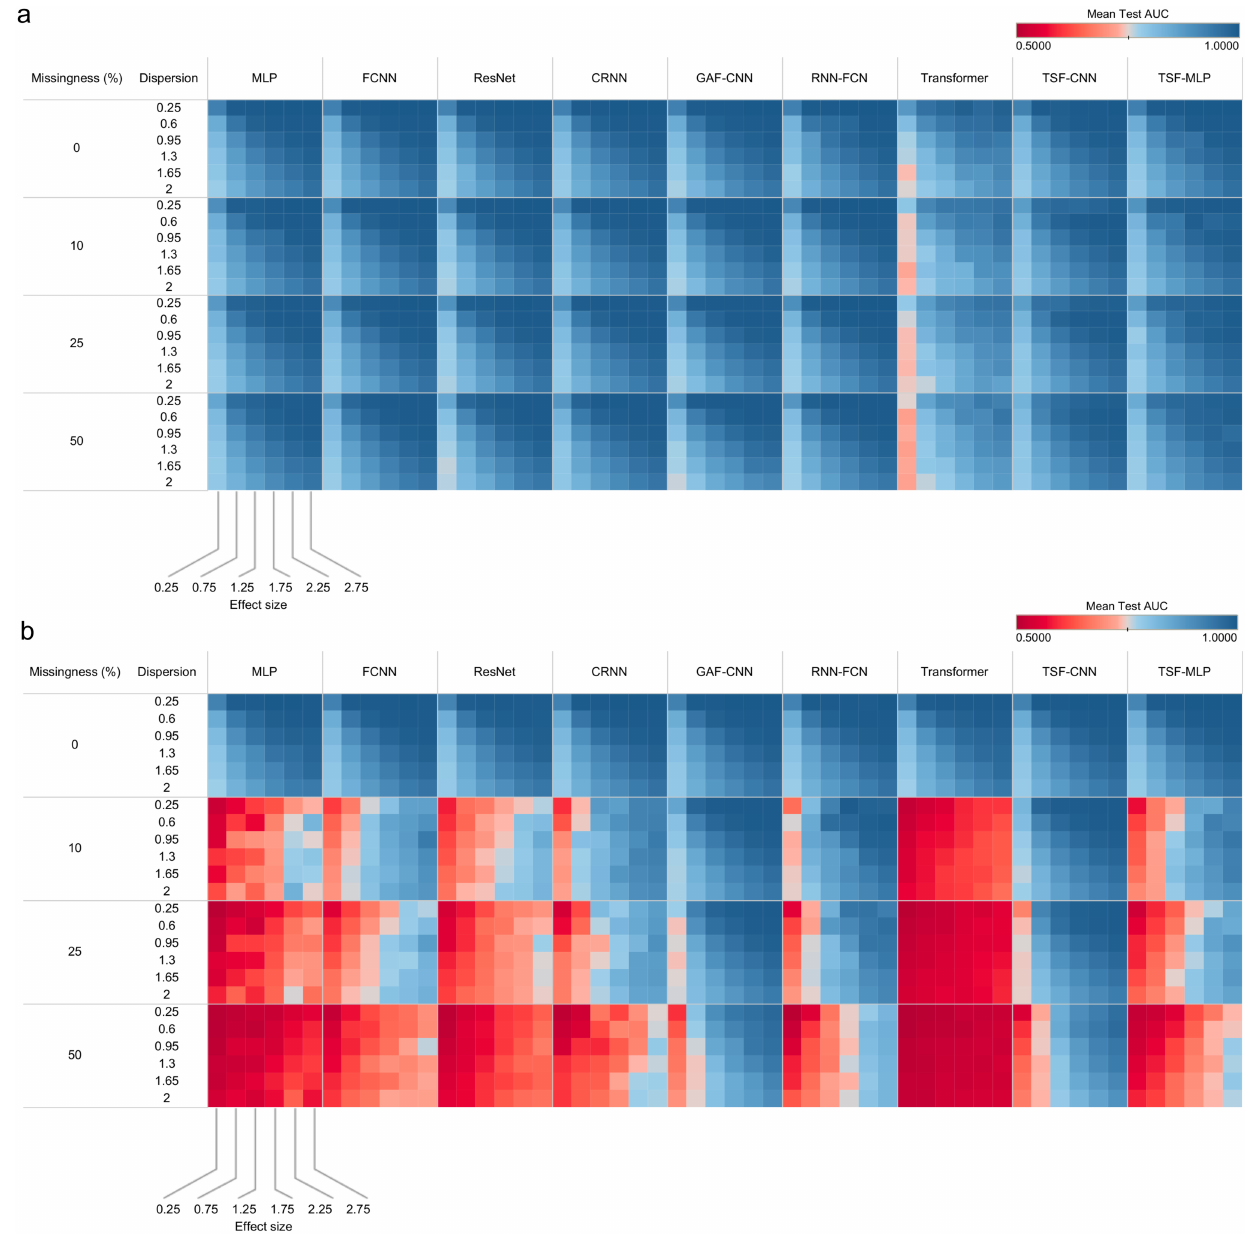
Fig. 2 Model predictive accuracies on simulated datasets by effect size, dispersion, and missingness. Cohorts include all class imbalance ratios, with no irregularity present ( a ) Mean area under the receiver operating characteristic curve (AUC) of the test set for the simulated magnitude cohort across BMI, SBP, and glucose cohorts. b Mean Test AUC for the simulated shape cohort across BMI, SBP, and glucose cohorts. The x-axis represents different effect sizes, and the y-axis represents different measures of dispersion, categorized by % data missingness. The colors are scaled by the mean AUC for each